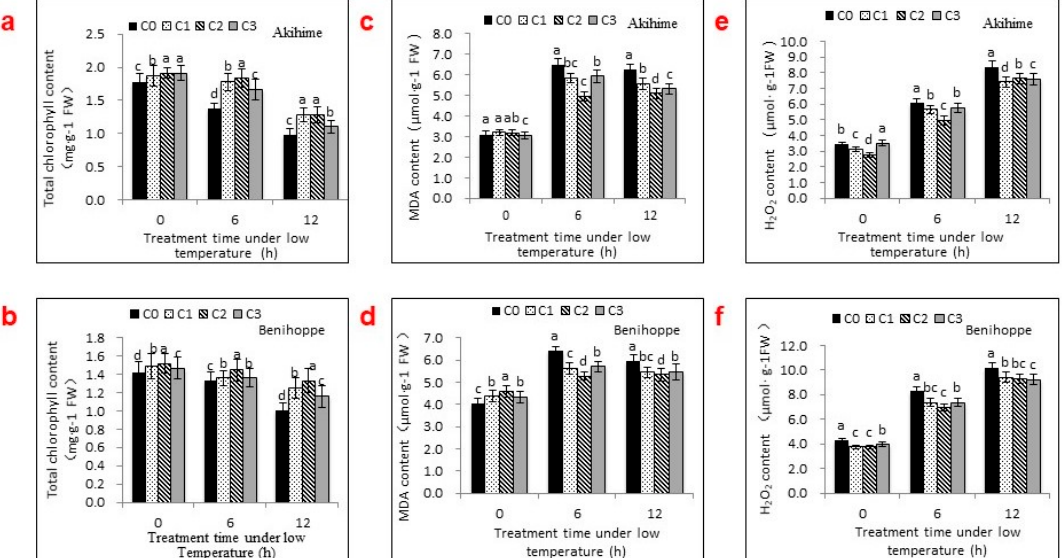
Figure 2. Effects of foliar spraying solutions containing different Se concentrations (C0, 0 mg · L − 1 ; C1, 2.5 mg · L − 1 ; C2, 5 mg · L − 1 ; C3, 10 mg · L − 1 ) on chlorophyll ( a , b ), MDA ( c , d ), and H 2 O 2 ( e , f ) contents in the leaves of two strawberry varieties under chilling stress. Bars with different letters are significantly different at the 0.05 level (LSD test).